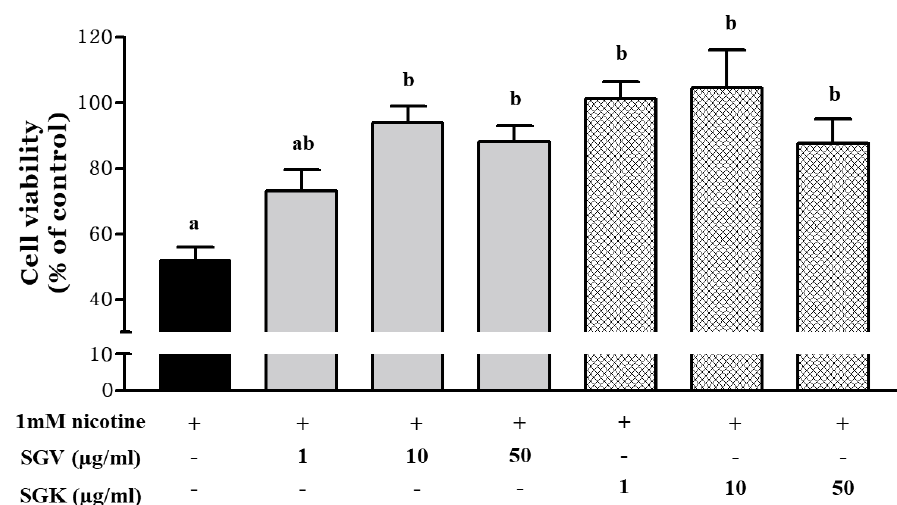
Figure 4. The protective effect of SGV and SGK on cell viability in HepG2 cells induced by 1 mM nicotine. Different letters show a significant difference at p < 0.05 between treatments. + means with treatment and - means without treatment.